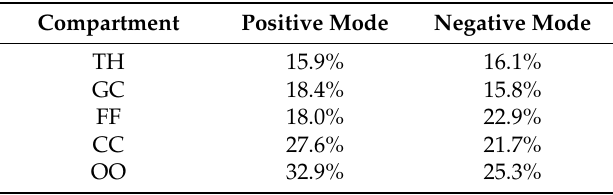
Table A2. Coefficients of variation (%) of normalized peak heights quantification from MALDI-TOF lipid profiles.